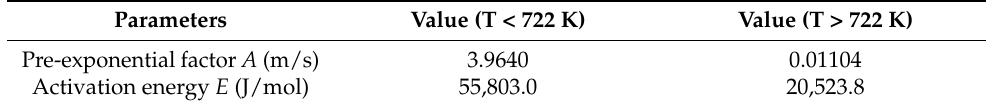
Table 3. Pyrolysis performance of HTPB